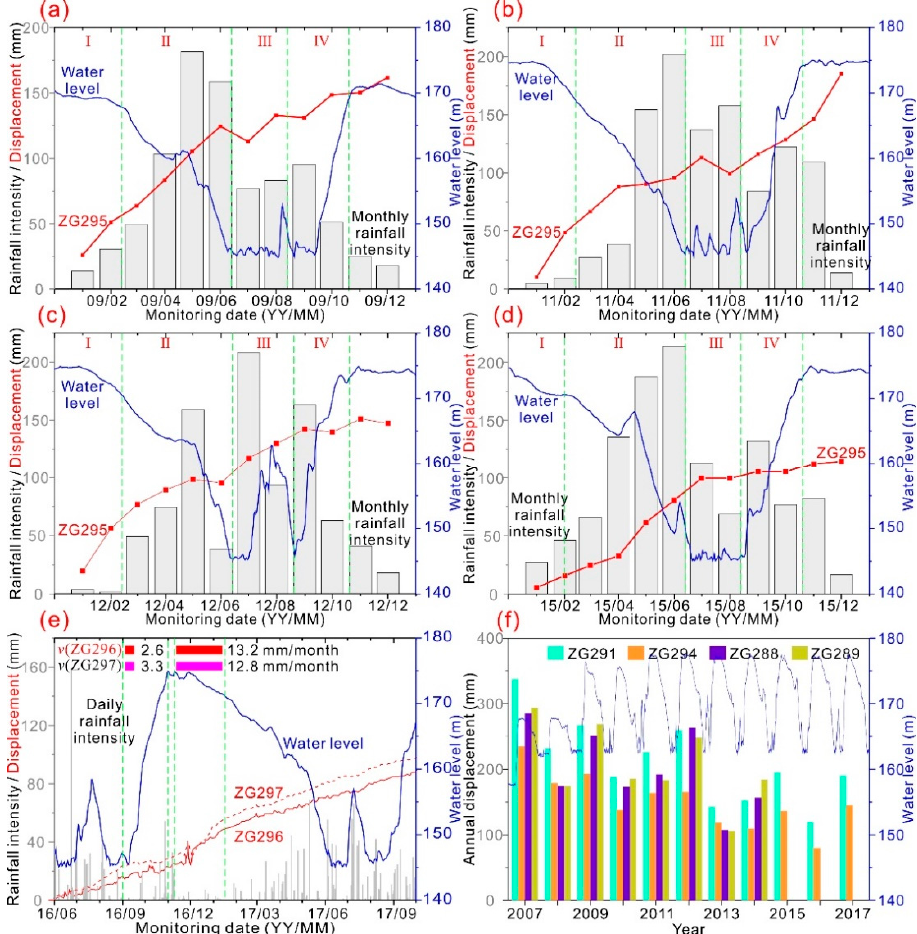
Figure 6. ( a – d ) Cumulative displacement at monitoring point ZG295, monthly rainfall intensity, and reservoir water level spanning the period of 2009, 2011, 2012, and 2015. ( e ) Cumulative displacement at monitoring points ZG296 and ZG297, daily rainfall intensity, and reservoir water level